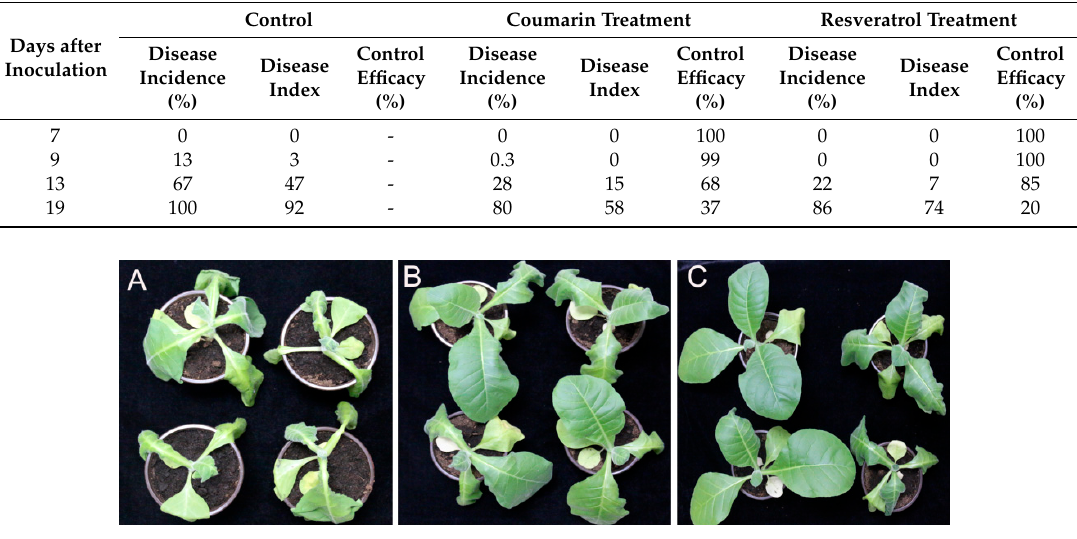
Figure 9. Control efficiency of sterile water (control) ( A ); resveratrol ( B ); and coumarin ( C ) in reducing wilting disease severity caused by R. solanacearum on tobacco seedlings at nine days post inoculation. The treatment concentration was 128 μ g/mL. The experiments were performed a minimum of five times.